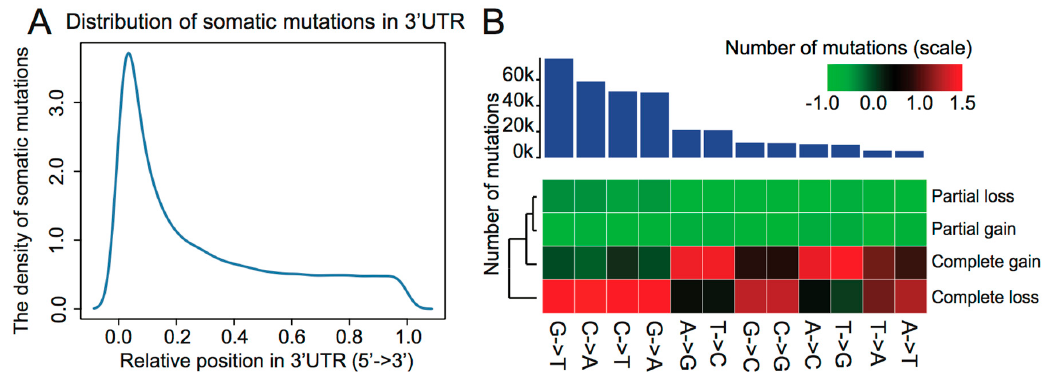
Figure 1. ( A ) The distribution of somatic mutations in 3 ′ -untranslated regions (3 ′ UTR). Horizontal axis represents the relative position of somatic mutations in 3 ′ UTR from 5 ′ to 3 ′ . Vertical axis represents the density of somatic mutations located in 3 ′ UTR. ( B ) Contributions of base substitutions in 3 ′ UTR mutations.